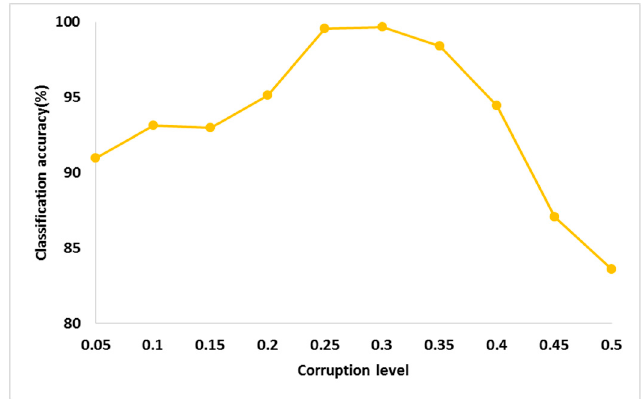
Figure 19. Classification accuracy of the proposed method with different corruption levels.